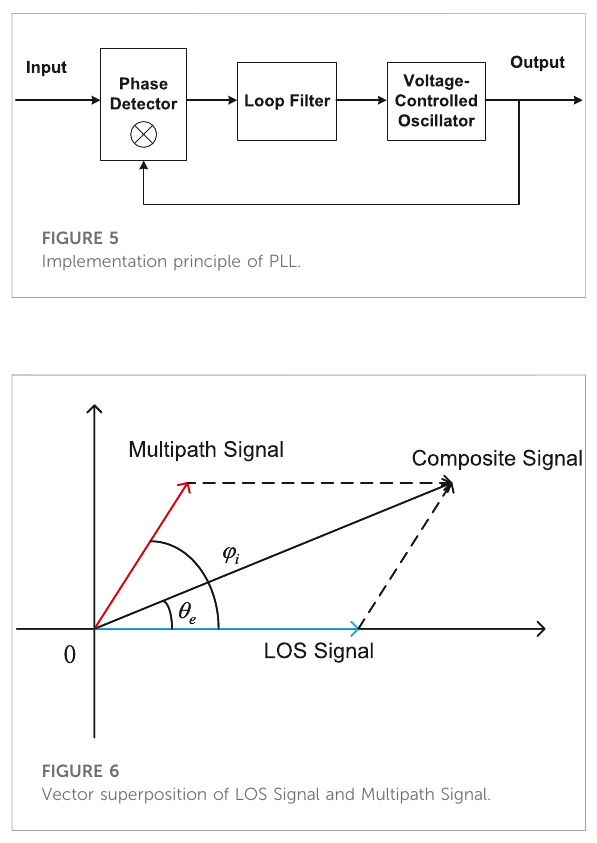
FIGURE 6 Vector superposition of LOS Signal and Multipath